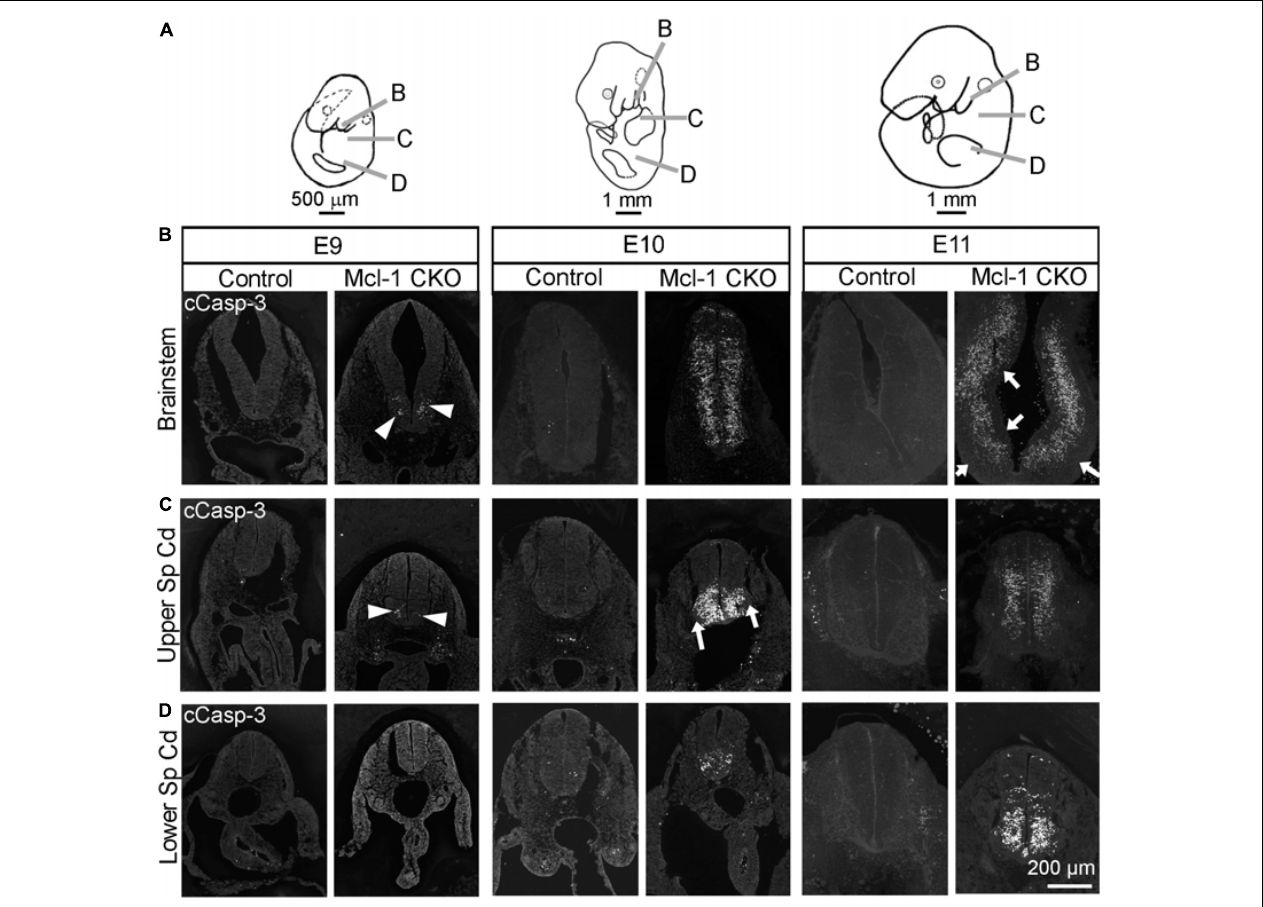
FIGURE 3 | Apoptosis spreads across to axes in the brainstem and spinal cord of Mcl-1 CKO embryos. (A) Line drawings of embryos demonstrating the location of sections collected from the brainstem and spinal cord. Immunohistochemistry for cCasp-3 on sections from the (B) brainstem, (C) upper spinal cord, and (D) lower spinal cord of wild type (Control) and Mcl-1 CKO embryos from E9 to E11 (E9, n = 3; E10, n = 2; E11, n = 4). Arrowheads point to clusters of apoptotic cells. Arrows indicate lateral and medial regions not immuno-positive for